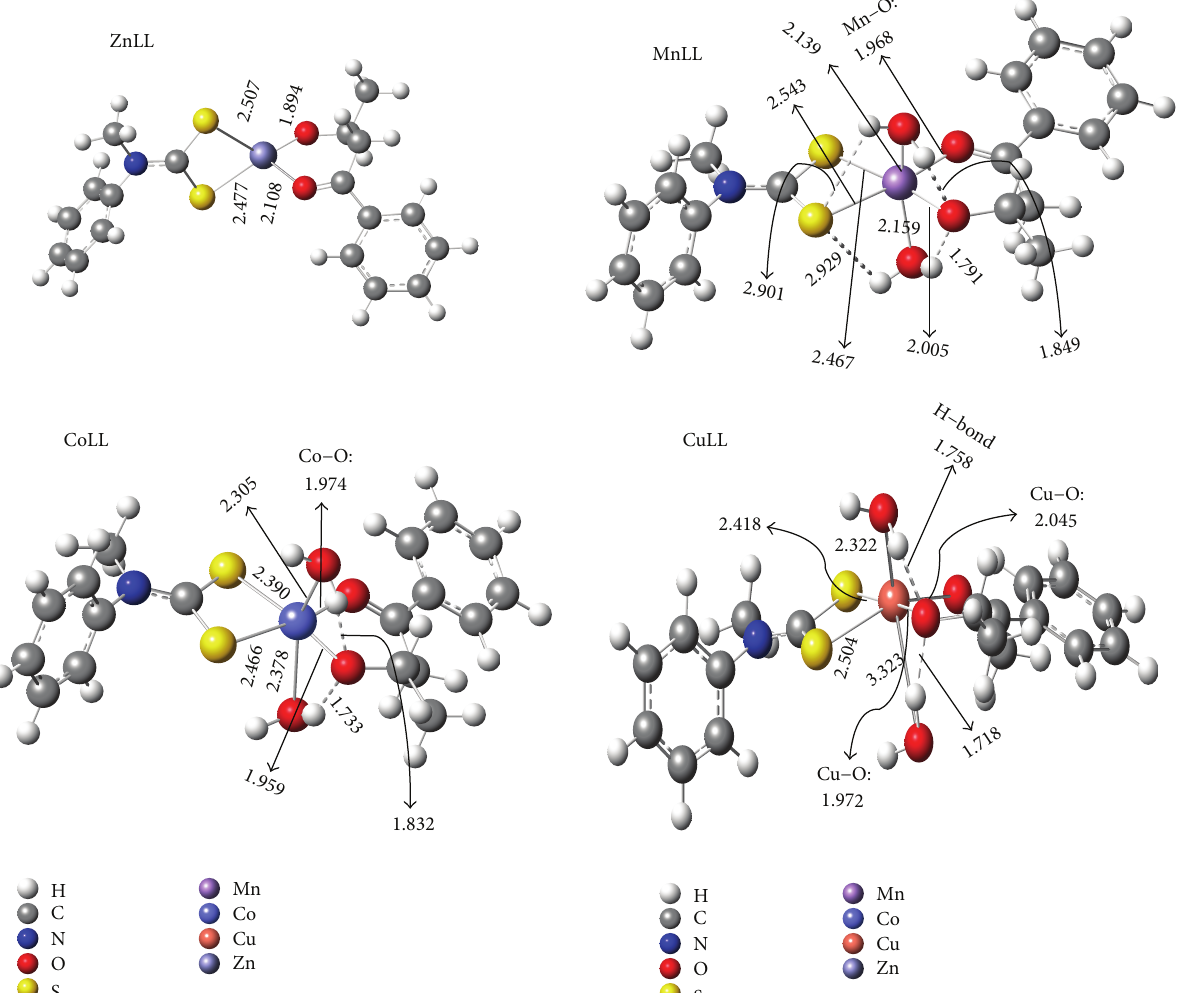
Figure 4: Optimized structures ZnLL 󸀠 , MnLL 󸀠 , CoLL 󸀠 , and CuLL 󸀠 at B3LYP/6-31+G(d,p). Selected bond lengths (˚A) that are relevant to the results and discussion are